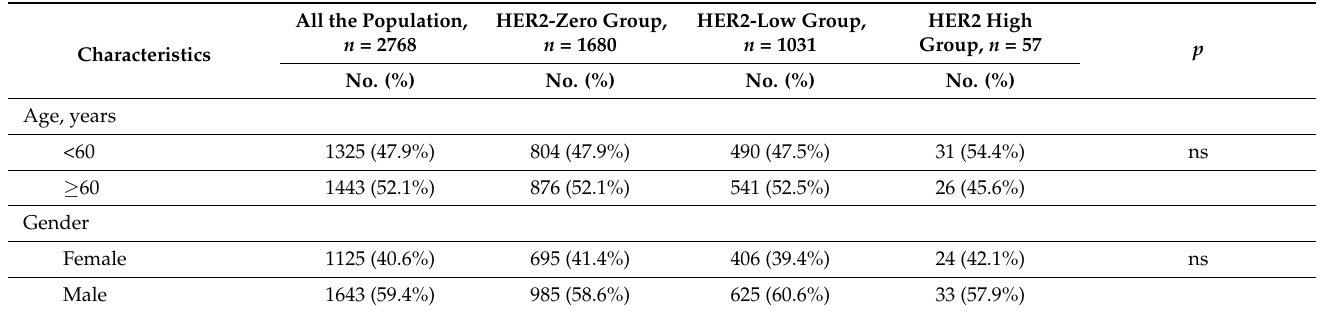
Table 1. Baseline clinicopathological characteristics of the overall